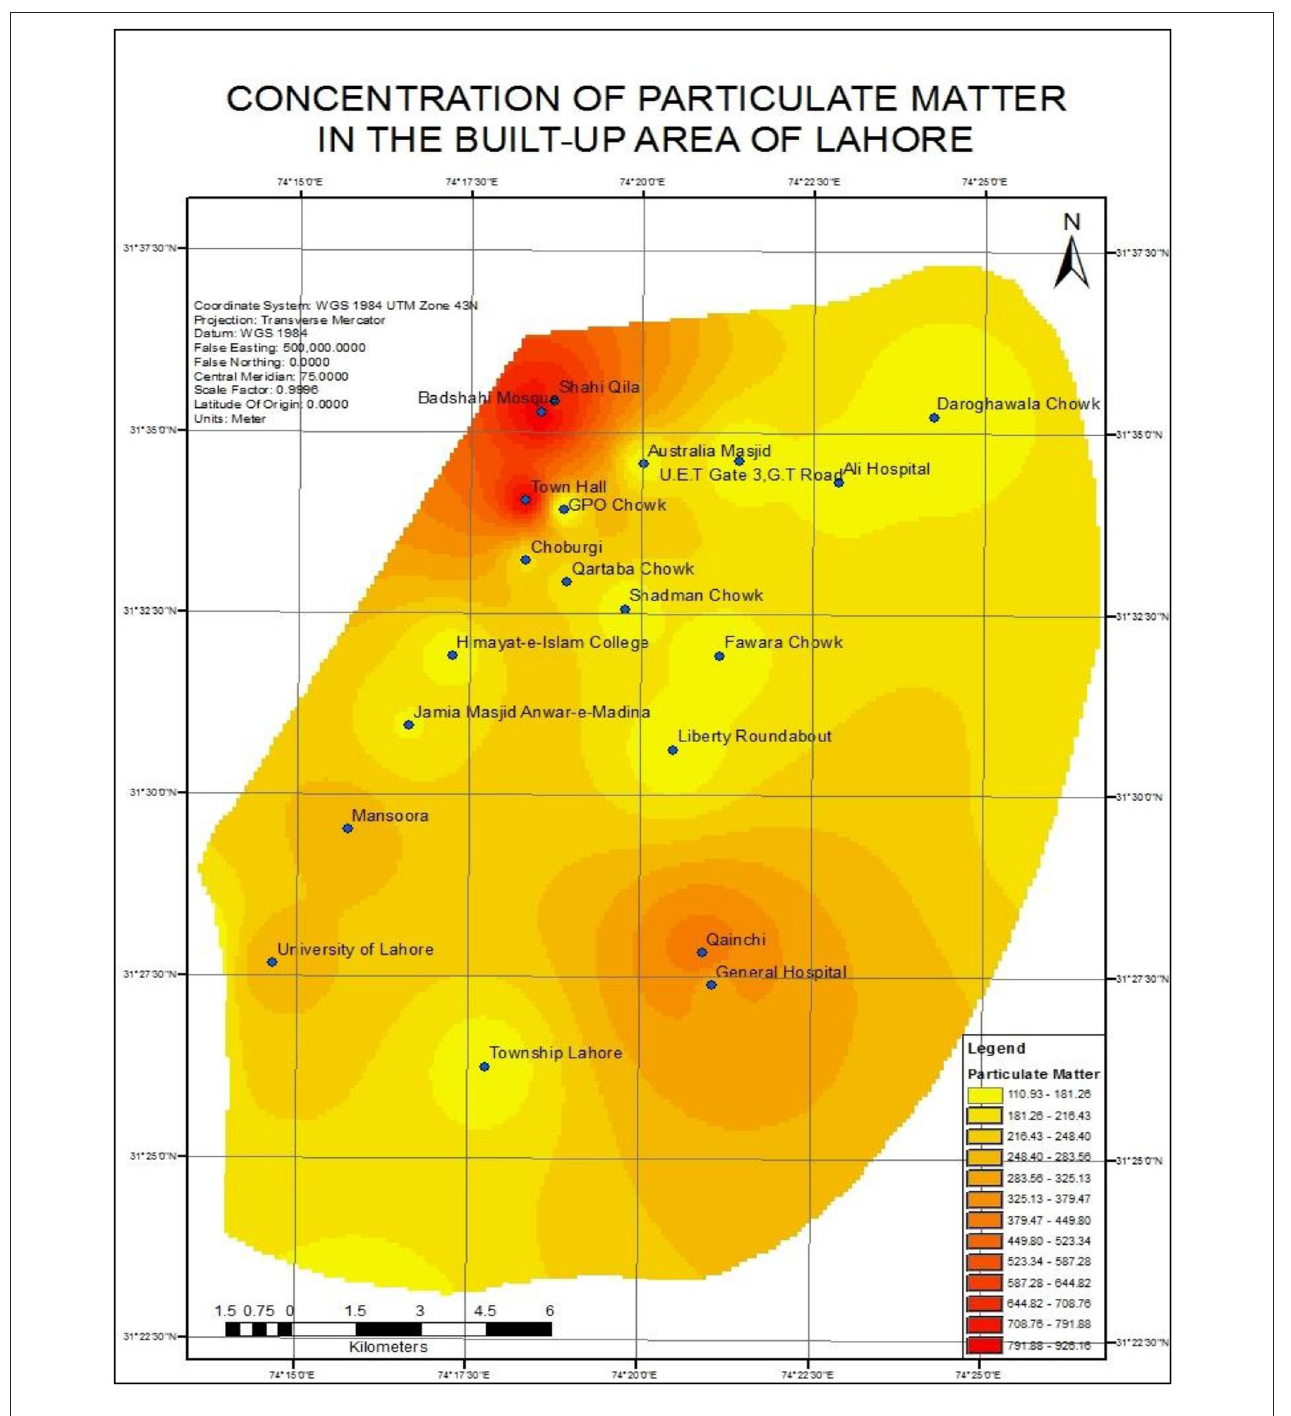
FIGURE 10 | Concentration of particulate matter.